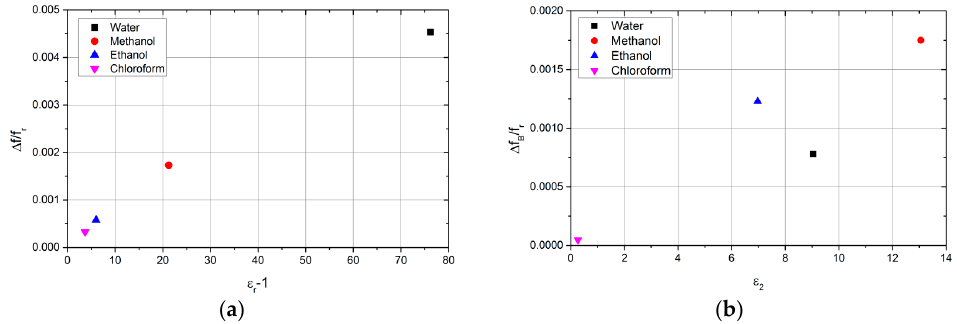
Figure 12. ( Δ f / fr ) for water, methanol, ethanol, and chloroform vs ε 1 -1 ( a ); and ( Δ f B / f r ) for the same Figure 12. ( ∆ f / fr ) for water, methanol, ethanol, and chloroform vs ε 1 -1 ( a ); and ( ∆ f B / f r ) for the same solvents vs. ε 2 ( b ). solvents vs. ε 2 ( b